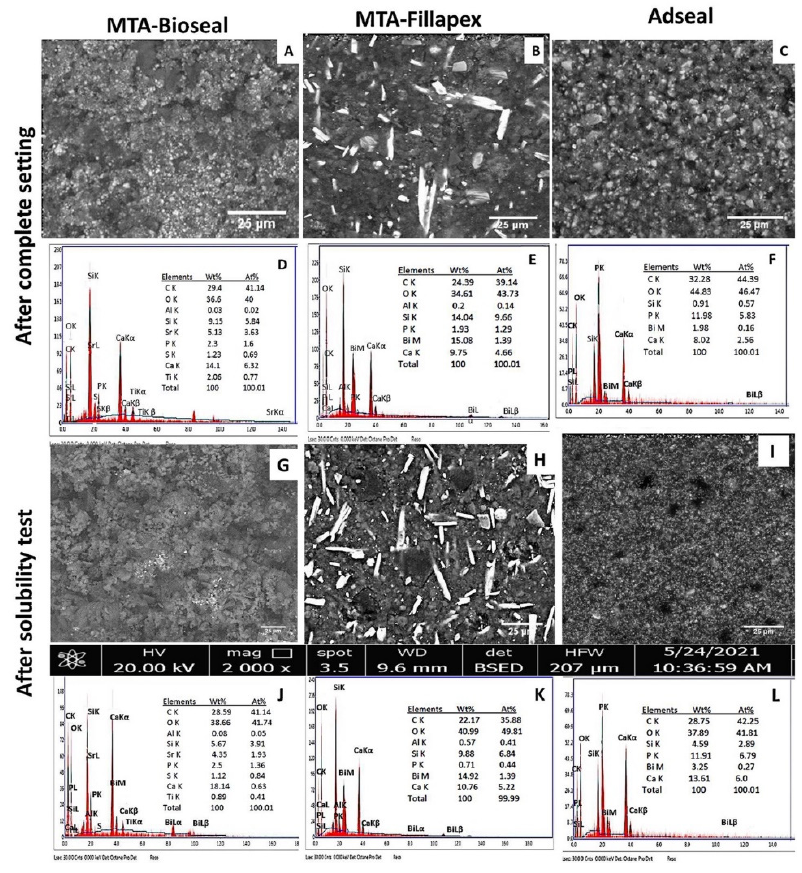
Figure 3. SEM examination of surface structure ( A – C ) and EDX analysis ( D – F ) of MTA-Bioseal, MTA-Fillapex, and Adseal before immersion in deionized water. SEM examination of surface structure ( G – I ) and EDX analysis ( J – L ) of MTA-Bioseal, MTA-Fillapex, and Adseal after immersion in deionized water for 28 days. Magnification ×2000.